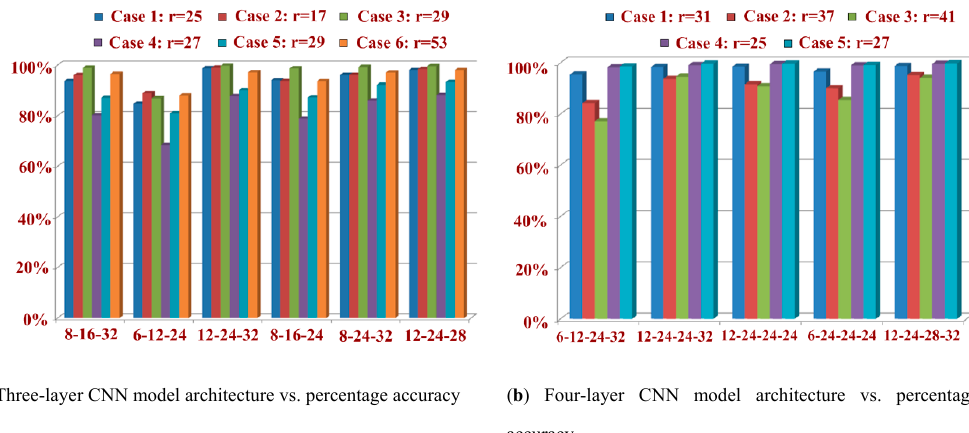
Figure 8. Receptive fields and recognition accuracies for CNN: ( a ) architecture having three layers; ( b ) architecture having four layers. ( b ) architecture having four